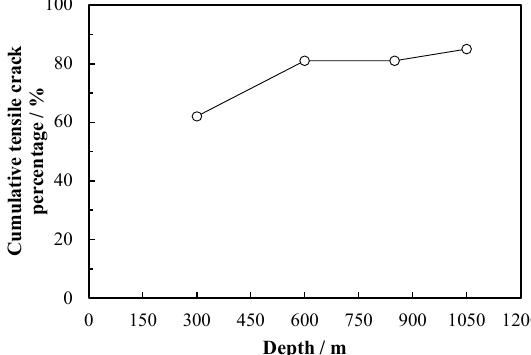
Figure 11. Cumulative tensile crack percentage in the overall triaxial unloading process of coal samples at different depths.